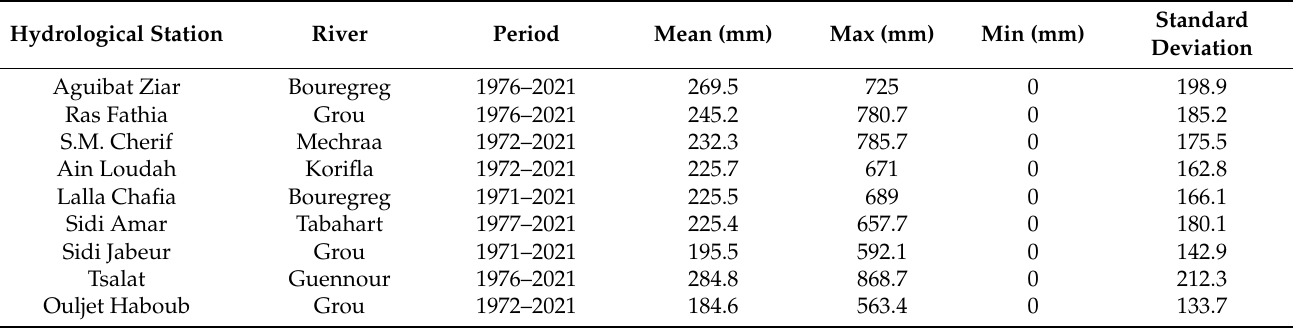
Table 2. Statistical characteristics of the monthly precipitation data recorded at nine monitoring rainfall stations.